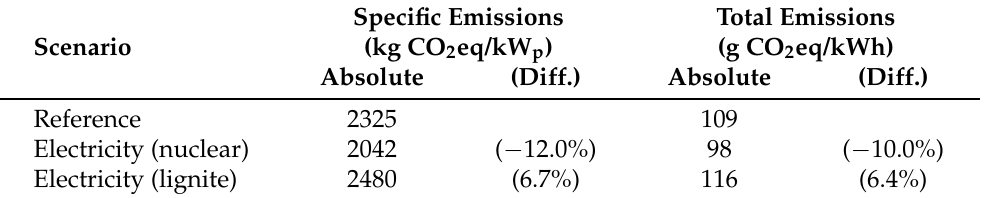
Table 4. Specific and total emissions for the solar PV scenarios (absolute values and relative difference as compared to the reference